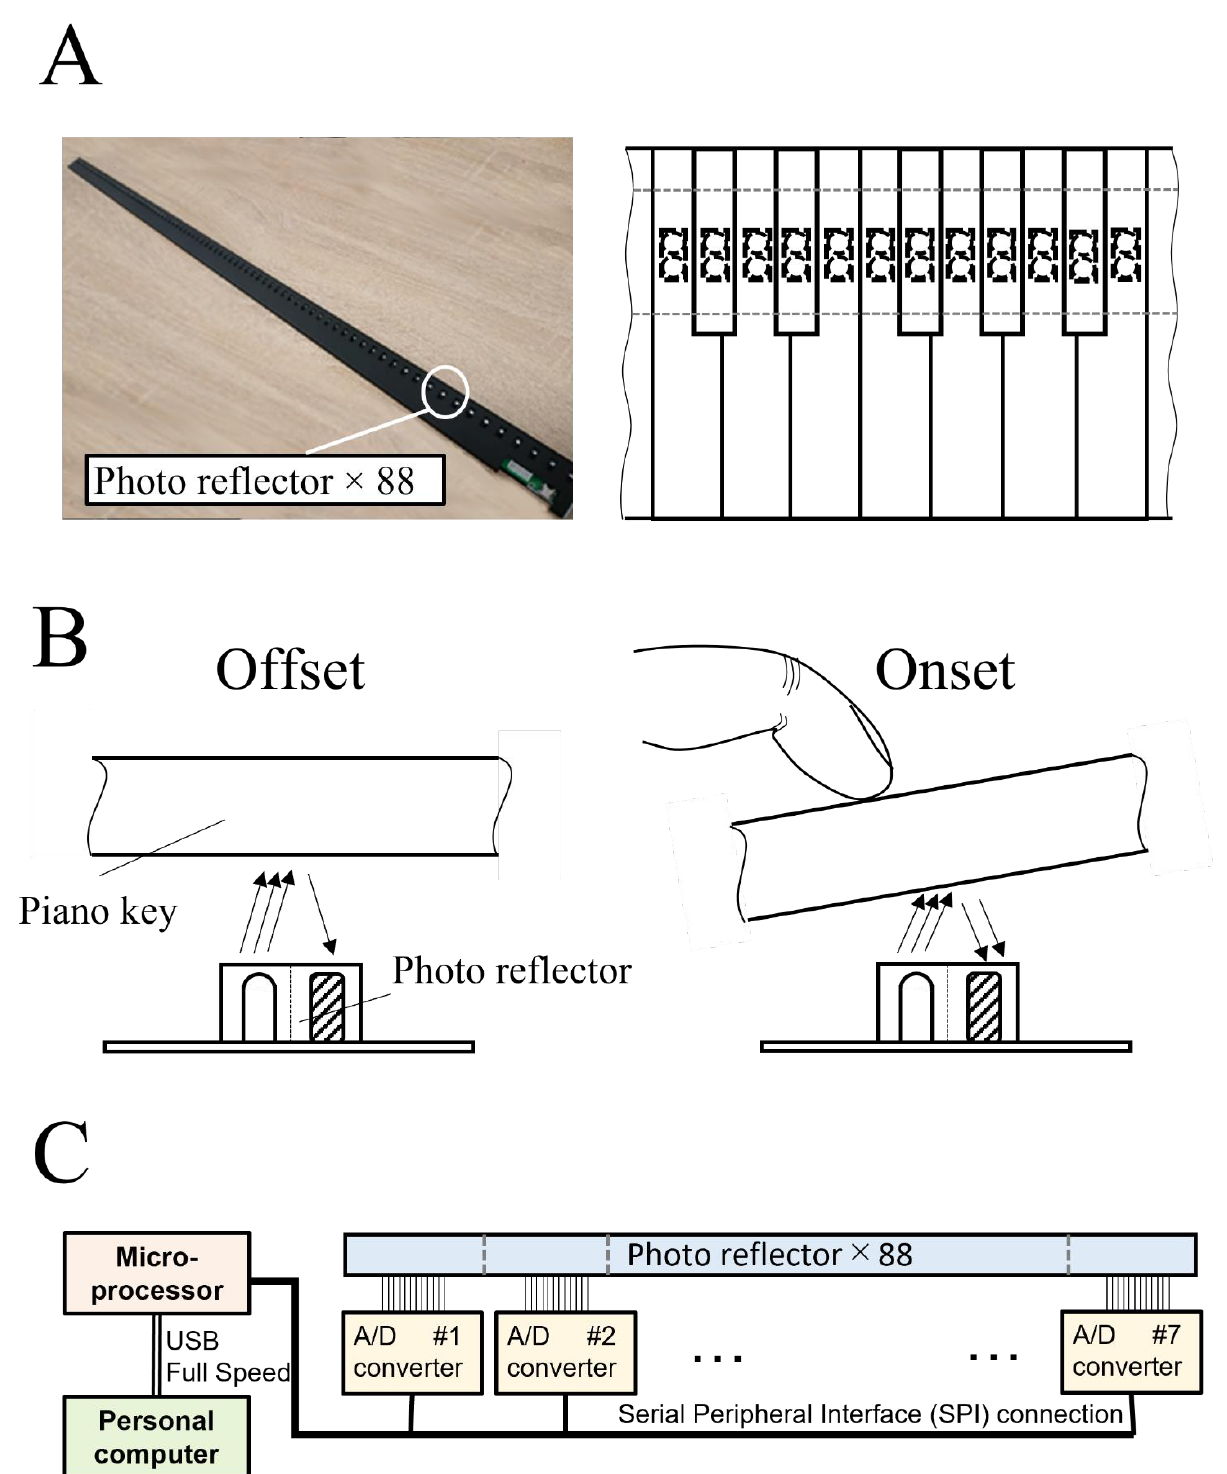
Figure 1. Schematic illustration of the system for sensing the key positions. ( A ) Each of the 88 photo reflectors was mounted beneath one piano key. ( B ) The photo reflector projected infrared light on the bottom surface of the key, and the derived voltage signal changed linearly with the distance between the photo reflector and the bottom surface of the key in relation to the intensity of the reflected infrared light. ( C ) System schematic of the sensing system.